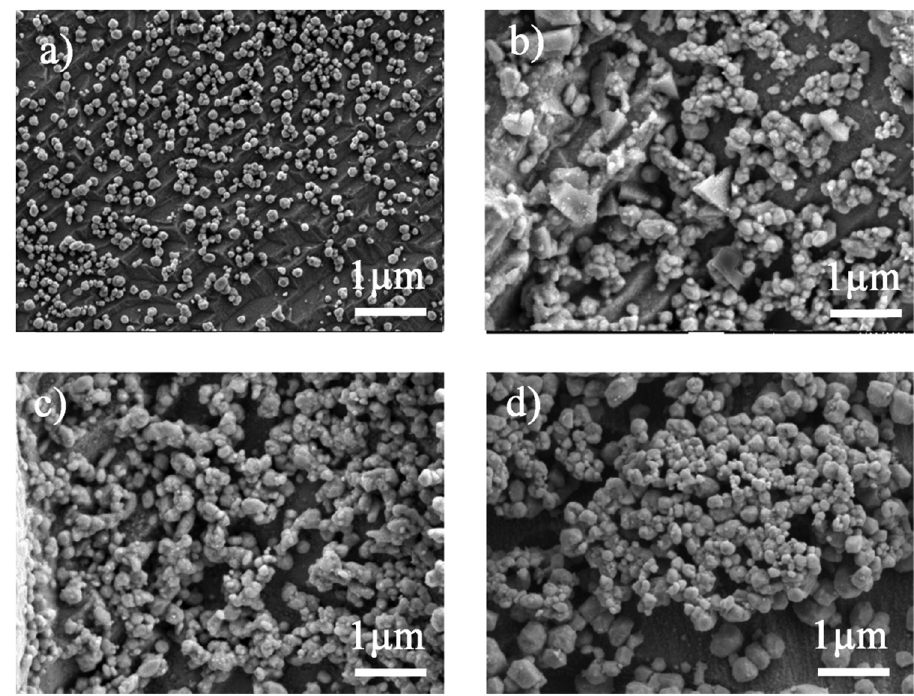
Figure 6: Ag particles adhering to the surface of the sample after corrosion: ( a ) 0 mm, ( b ) 1 mm, ( c ) 3 mm, and ( d ) 5